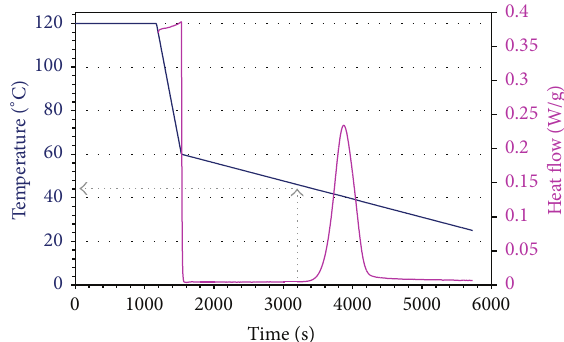
Figure 1: Temperature and calorimetric evolution during prelimi- nary DSC test.